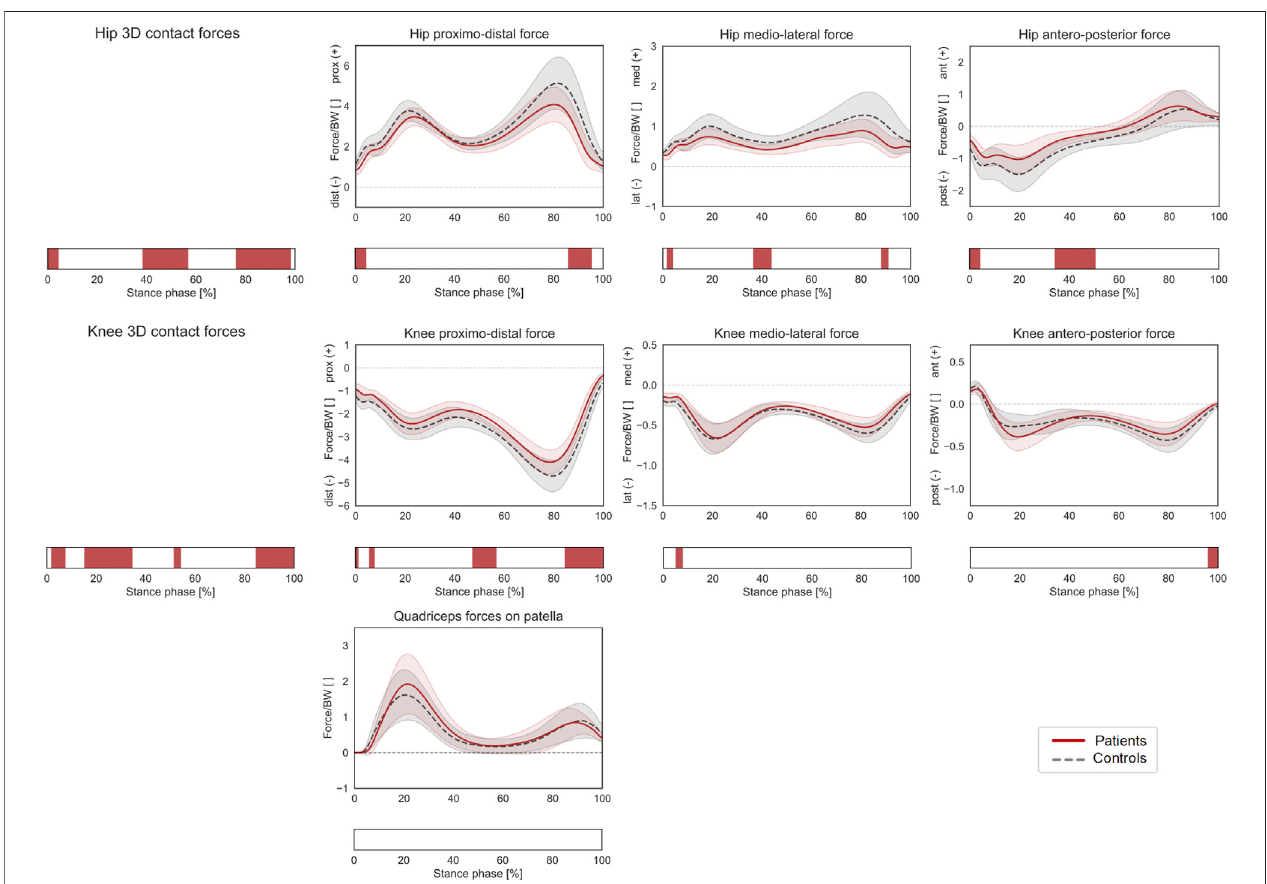
FIGURE3| Jointforcesduringstancephase(ST).Mean±1SDhipandkneeproximo-distal,medio-lateral,andantero-posteriorcontactforces,aswellasresultant forceexertedbythequadricepsmusclesonthepatella,arereportedasredsolidlinesforpatients,andasgreydashedlinesforcontrols.IntervalsofSTwithastatistically signi fi cant difference in the relevant SPM tests are reported as red bars. Knee and hip contact forces were regarded as a 3D vector fi elds. 3-dimensional signi fi cant differencesbetweenpatients andcontrolswereanalyzedbymeansoftwo-sampleHotellingT2testsandarereportedintheleftmostpanels.Theresultantforceon the patella, as well as individual components of the vector fi elds in the post-hoc vectorial analyses, were analyzed by means of two-sample t-tests and intervals characterized by signi fi cant differences between the two groups are reported below each subplot.